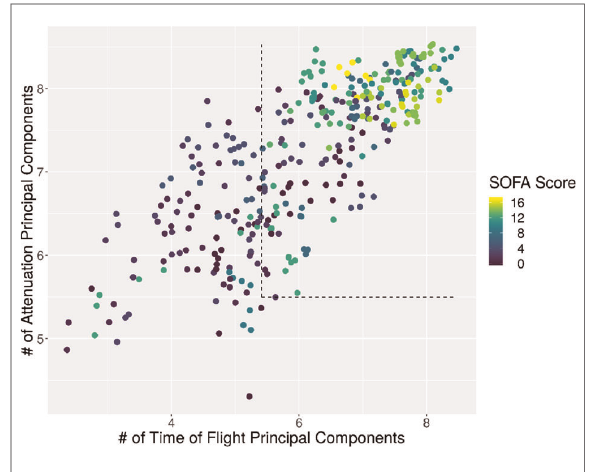
FIGURE 11 Scatterplot of the trained principal components. Each point represents a measurement of a patient at a given time; the points are colored according to the respective SOFA score.